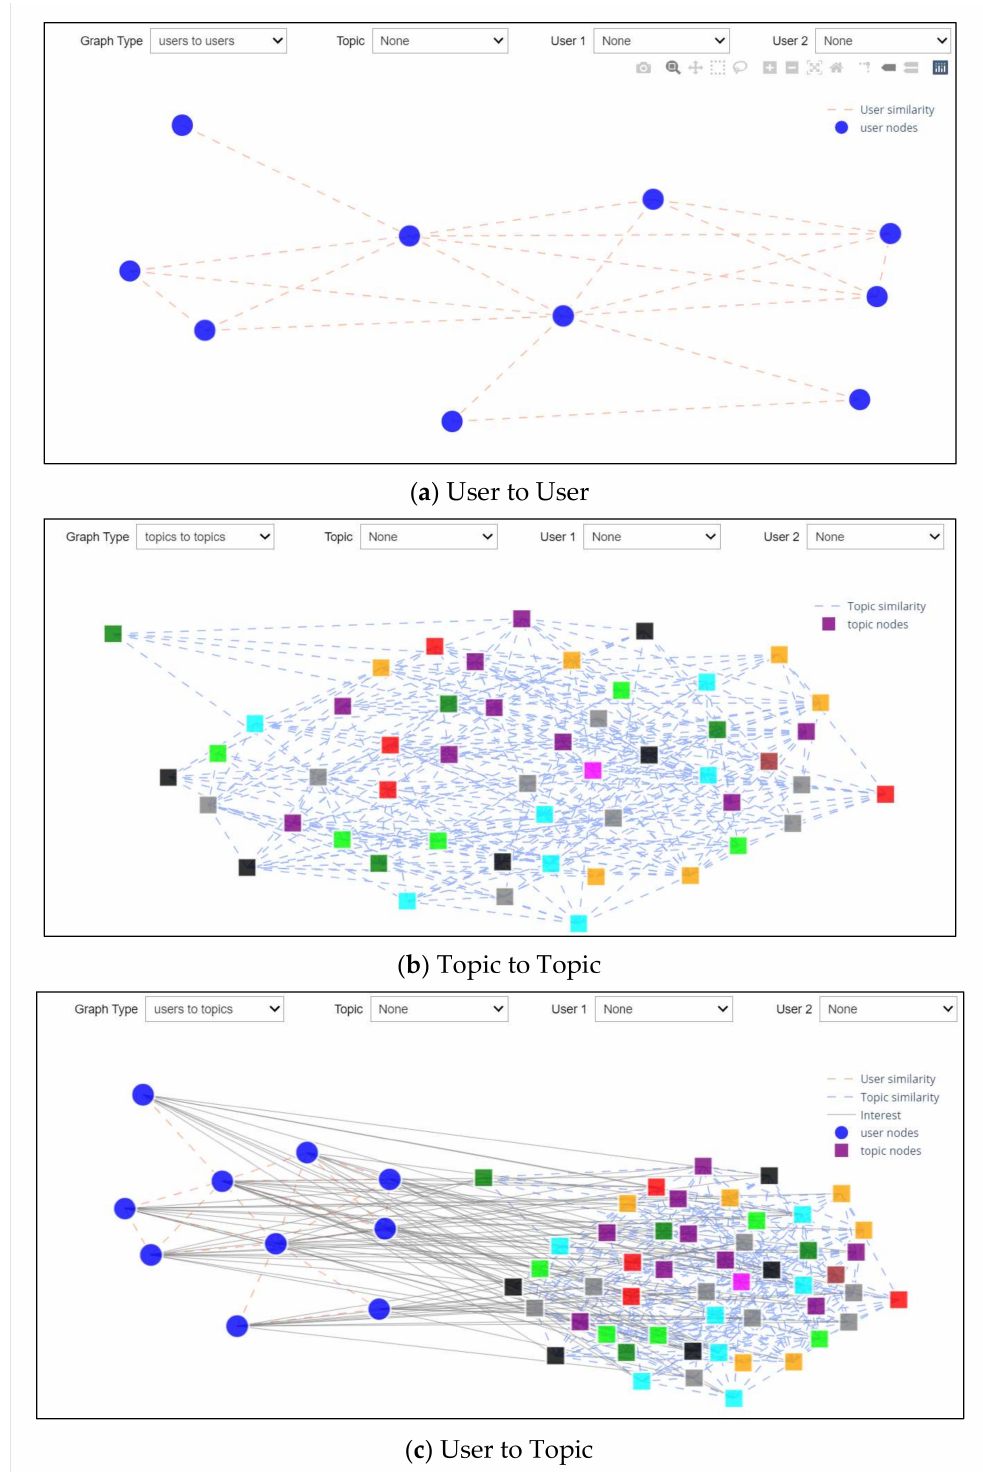
Figure 13. Graph-Types